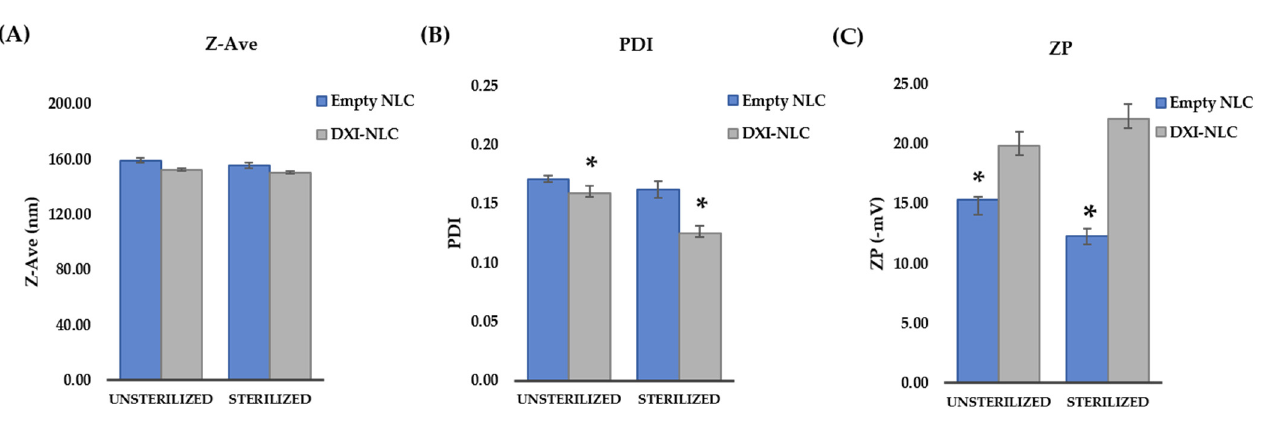
Table 7. IC 50 values of DXI-NLC and empty NLC at several incubation